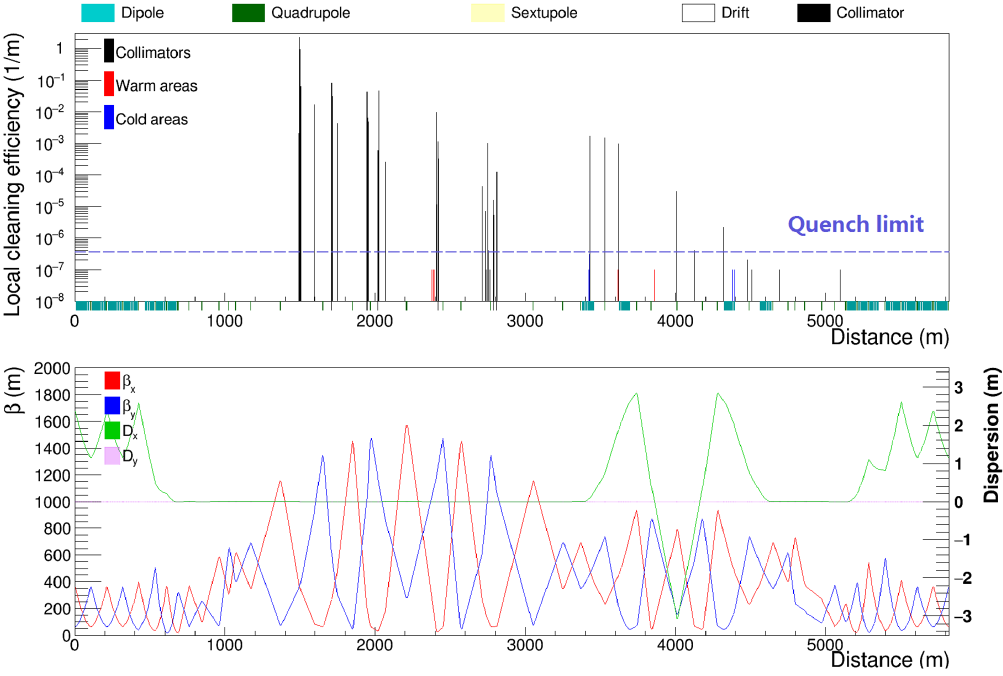
FIG. 10. The proton loss distribution of the cleaning insertion with protective